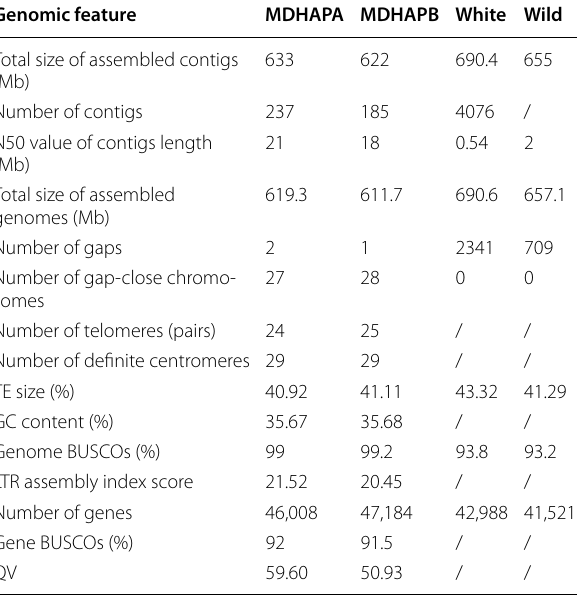
Table 1 Summary of genome assembly and annotation of